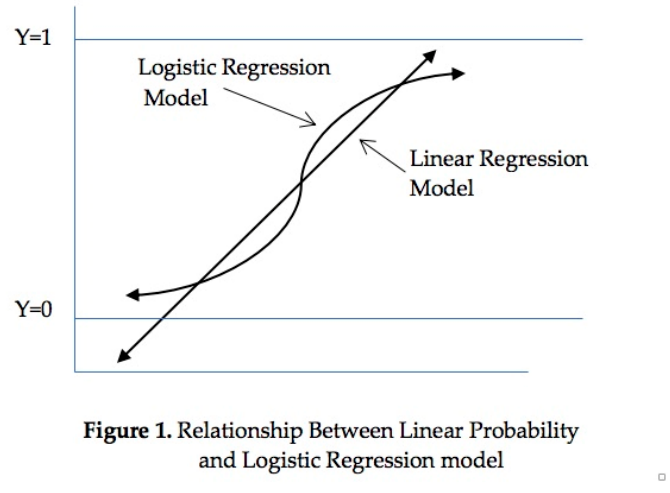
Figure 1. Comparison of Linear Probability to Logistic Regression.